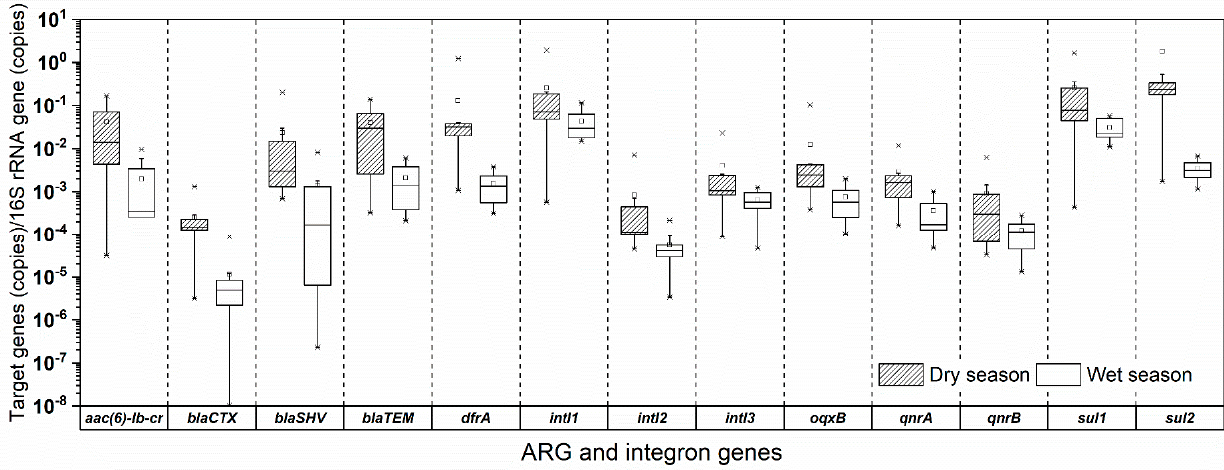
Figure 3. Seasonal variations in the relative abundance of ARGs and integrons in the Saigon River in the wet and dry seasons. The lower and upper “ × ” symbols in each box indicate the 1% and 99% percentiles of data points. The squares in the boxes indicate the mean values of the data points.